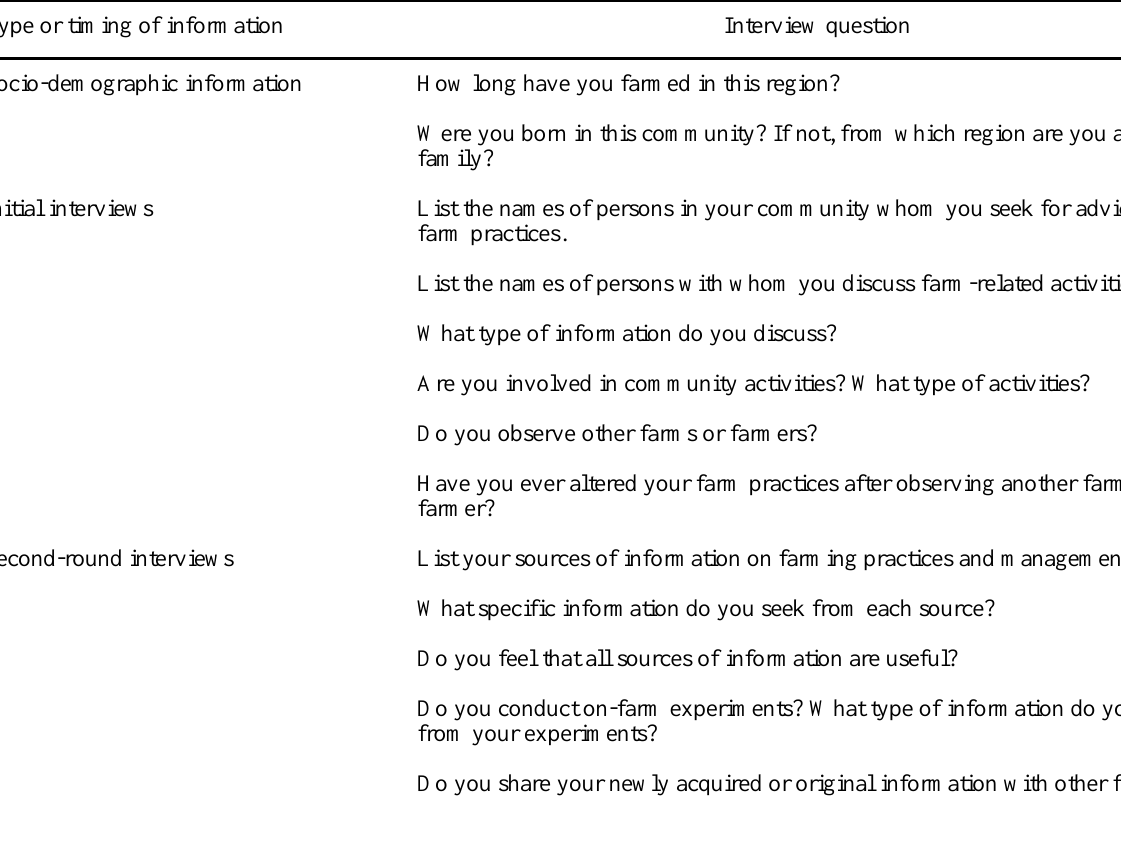
Table 1. Summary of questions used to collect socio-demographic information and specific information on farming activites during initial interviews and second-round interviews performed 1 yr